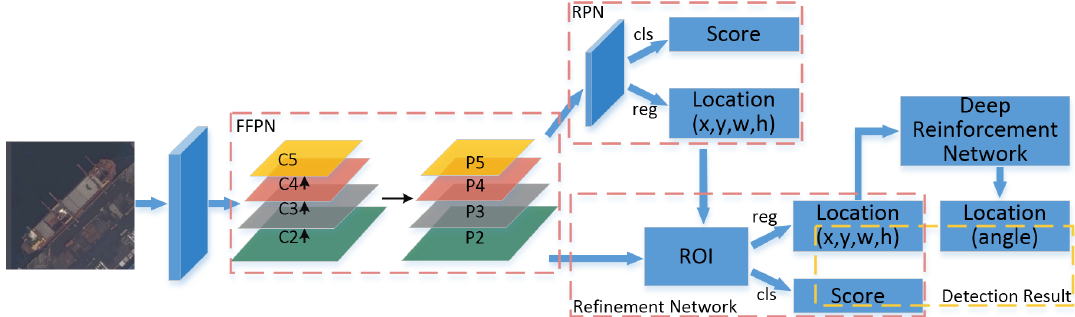
Figure 1. Feature Fusion Pyramid Network and Deep Reinforcement Learning (FFPN-RL) ship detection